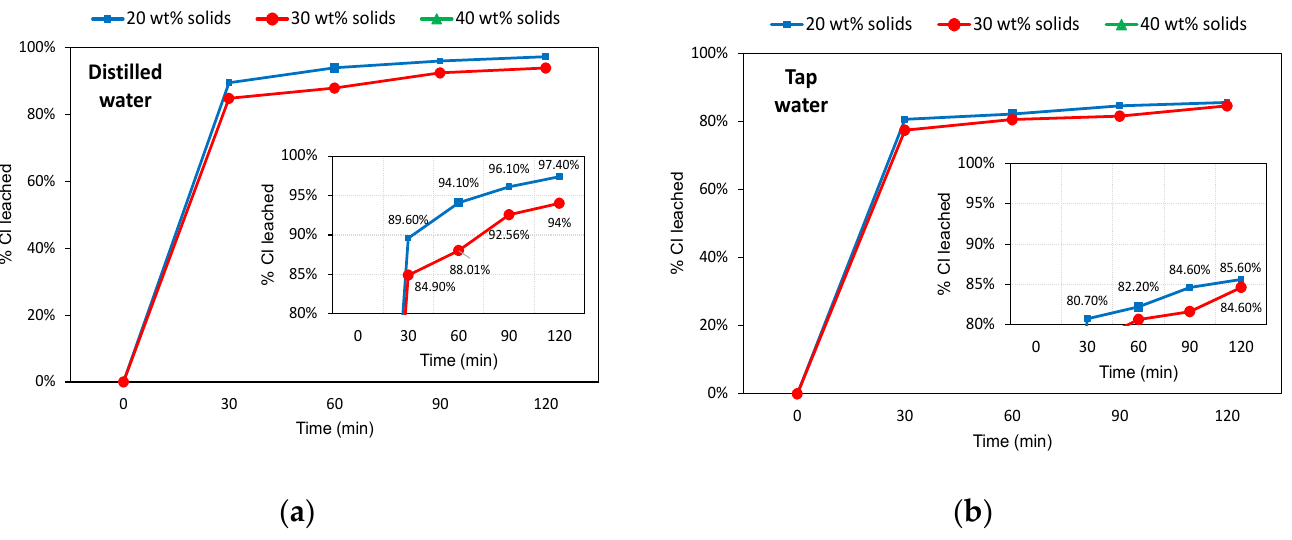
Figure 4. Leaching efficiencies (% Cl removed) over time for the − 19 mm slag samples. ( a ) Distilled water system; ( b ) Tap water system.